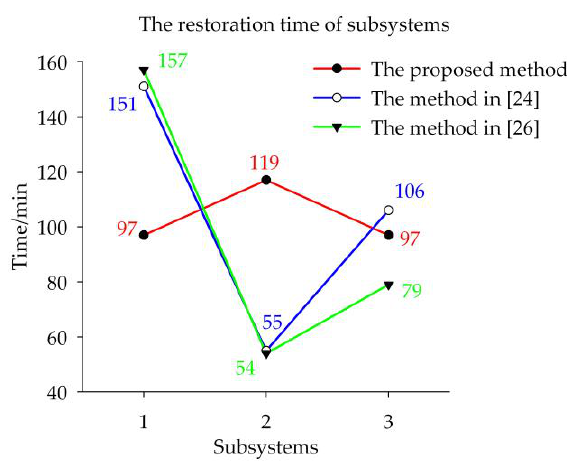
Figure 8. The restoration time of subsystems using different methods.